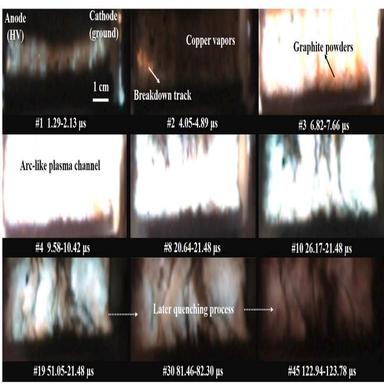
Self-emission images of exploding a copper wire in a tube with preplaced graphite powders at a stored energy of 250 J.